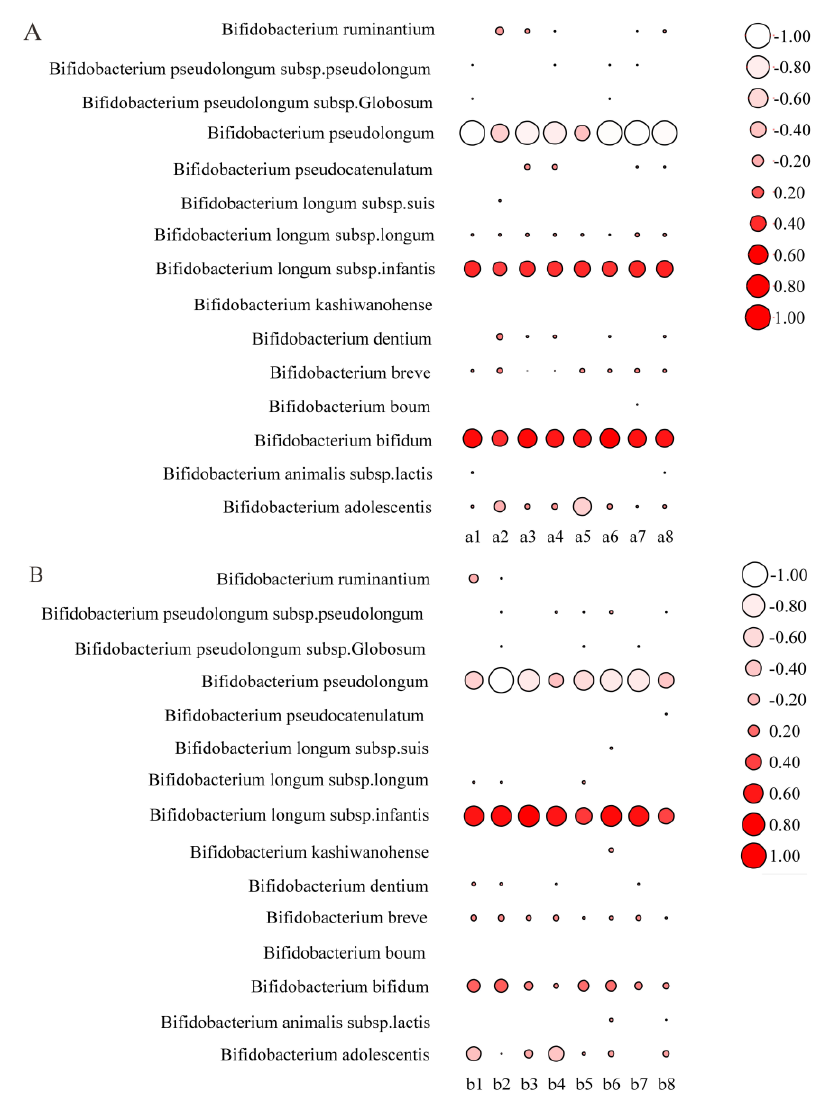
Figure 9. Bifidobacterium composition analysis of mixed strains group ( A ) and mixed strains + 2 ′ FL group ( B ) (n = 8 for each group). a1–a8 represents different samples of the mixed strains group; b1 – b8 represents different samples of the mixed strains + 2 ′ FL group. The size of the circle represents the relative abundance. The negative value represents a decrease in the relative abundance after intragastric administration, while the positive value represents an increase in the relative abundance after intragastric administration.